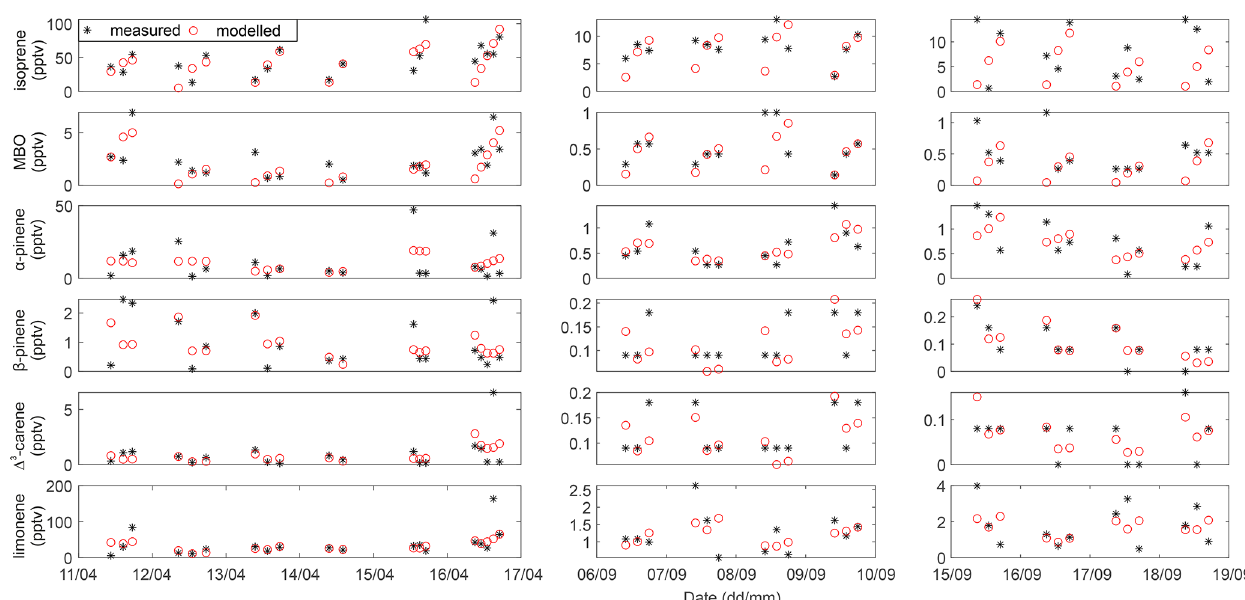
Figure A1. Measured and modeled mixing ratios of